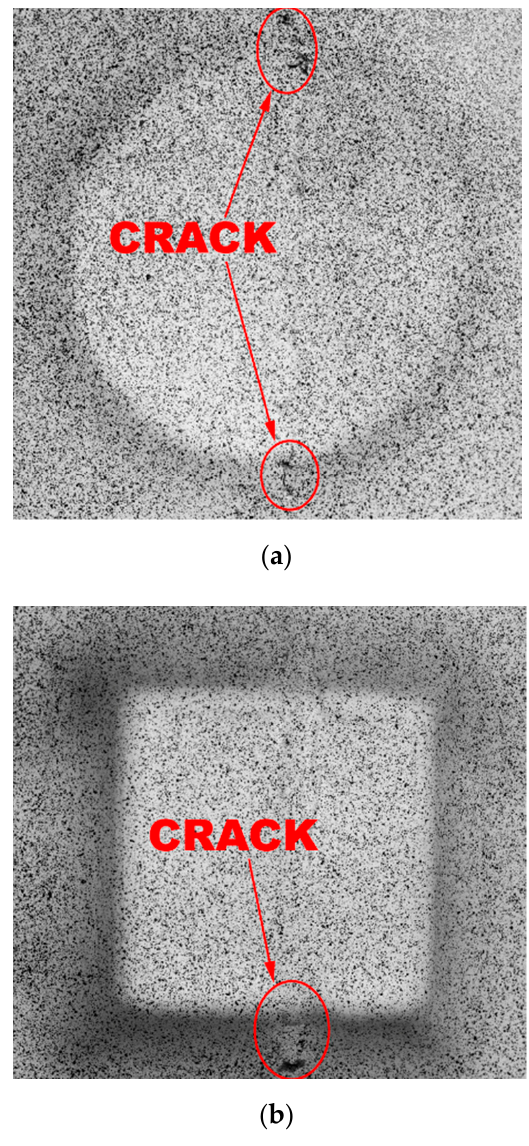
Figure 6. The cracks that appears for one side welded blanks for truncated cone-shaped parts ( a ) and for truncated pyramid-shaped parts ( b ).